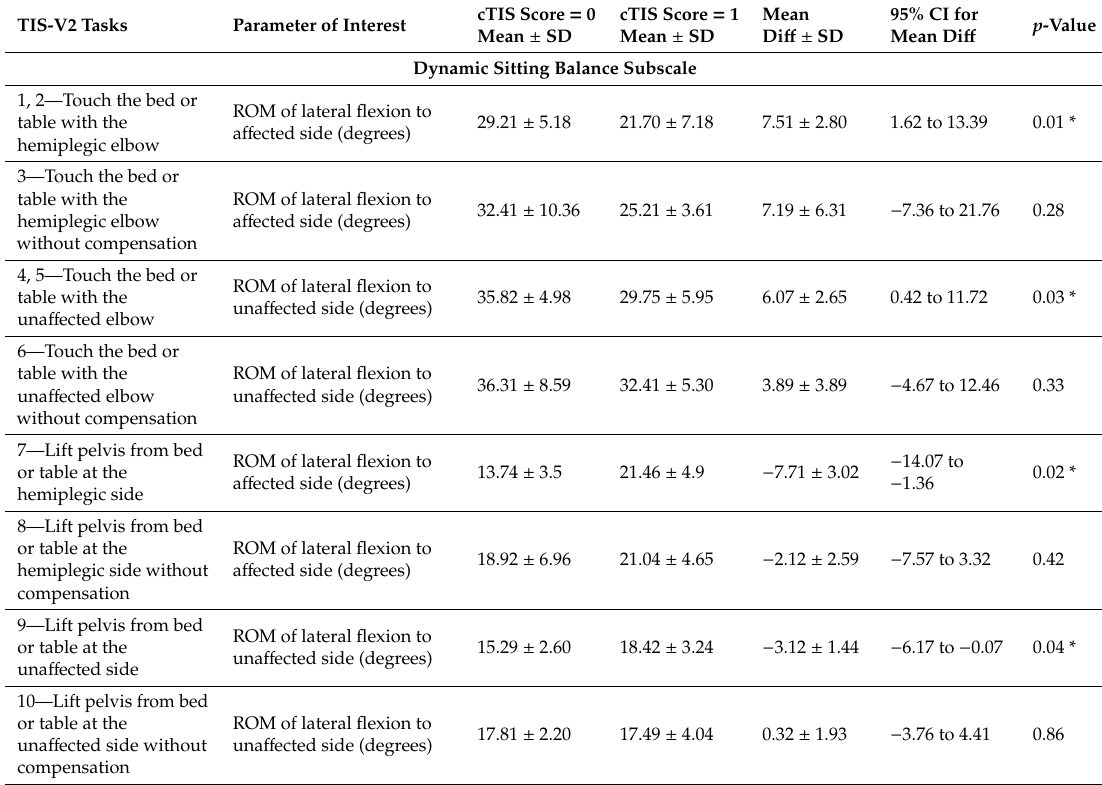
Table 6. Di ff erences in iTIS parameters between stroke participants scoring zero, one and two on the clinical